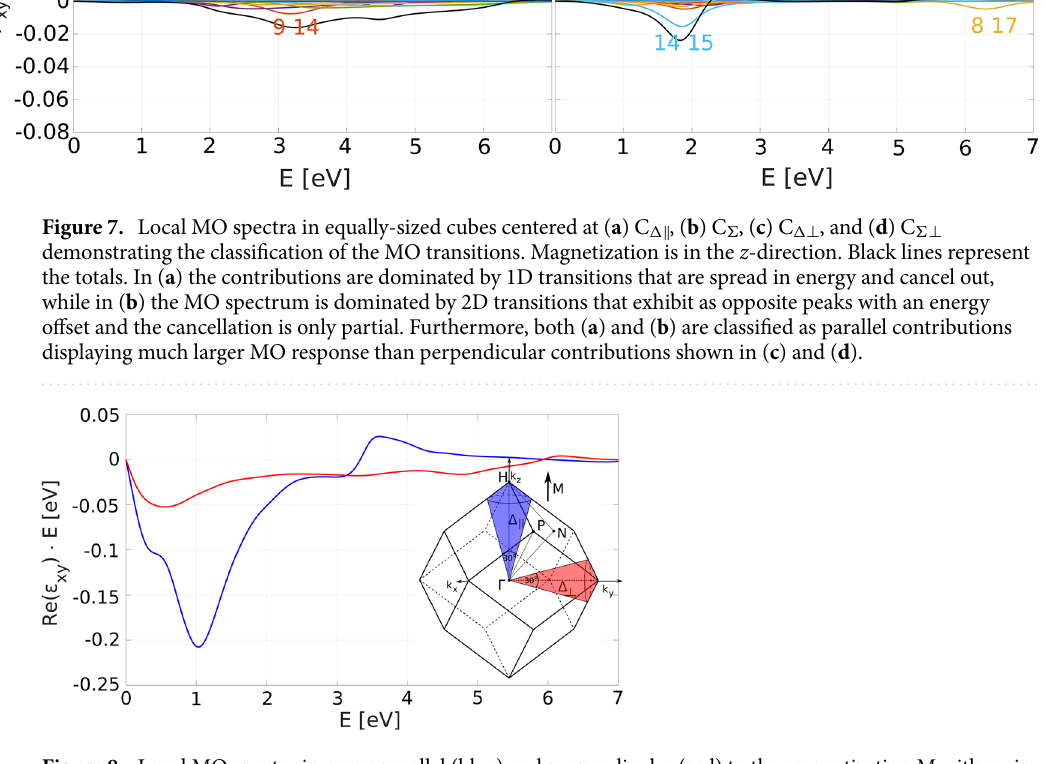
Figure 8. Local MO spectra in cones parallel (blue) and perpendicular (red) to the magnetization M with main axes (cid:31) (cid:31) and (cid:31) ⊥ , respectively. The parallel contributions dominate in the entire spectral